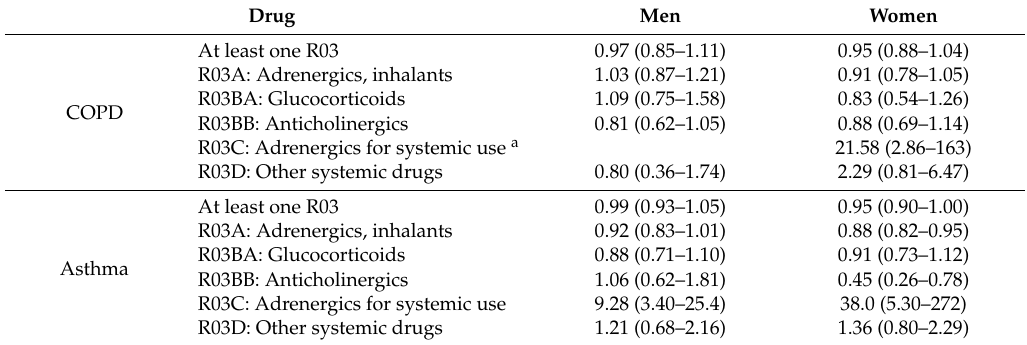
Table 5. Relative risks (RRs) with 95% confidence intervals (CIs) for ID versus gPop stratified by sex and diagnoses of COPD and asthma.